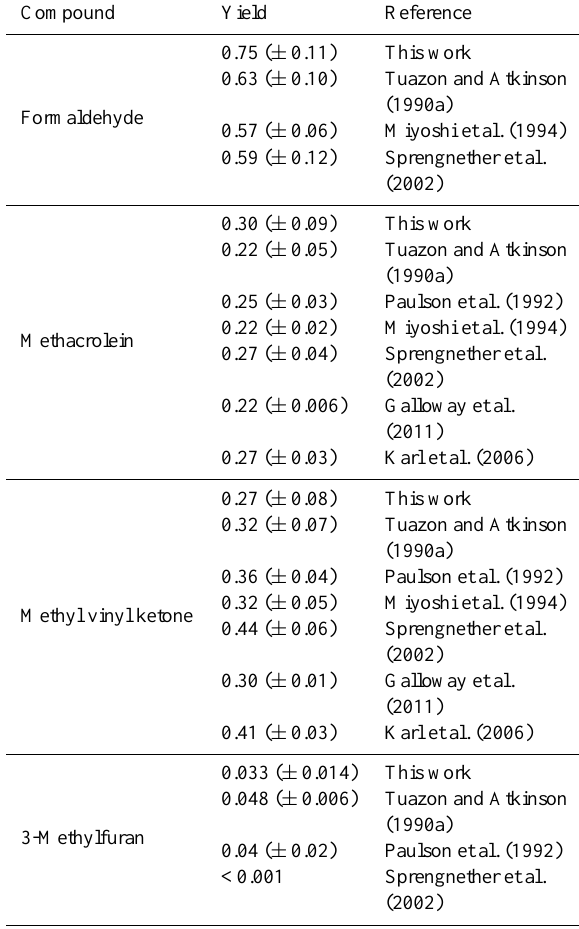
Table 2. Yields of first-generation oxidation products during iso- prene photooxidation compared with previous studies. Values in parentheses are 2-sigma